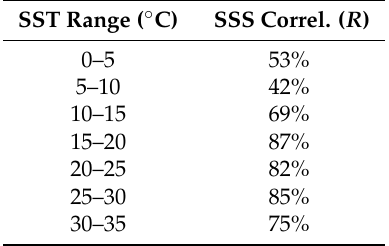
Table 6. Salinity correlation factor R in test data for different temperature ranges in training